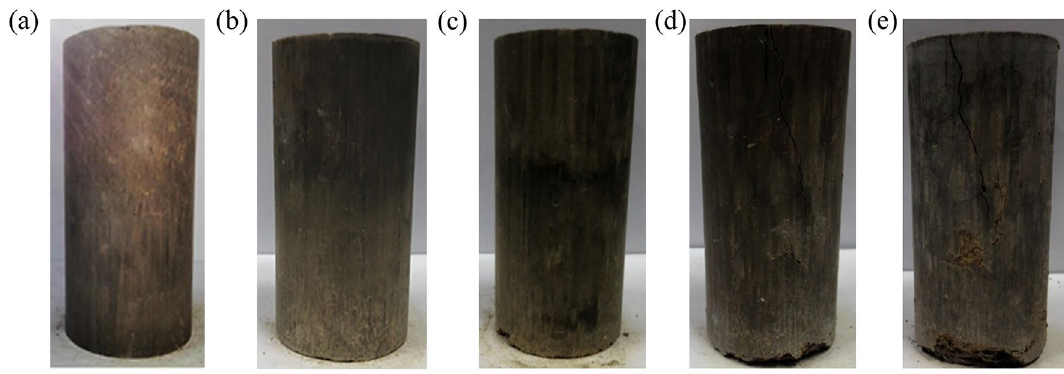
Figure 4. Appearance changes of cured chromium contaminated soil samples with dry and wet cycles at ( a ) 0 times; ( b ) 2 times; ( c ) 4 times; ( d ) 8 times; and ( e ) 16 times.